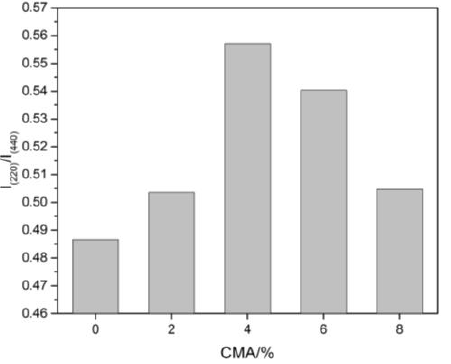
Figure 3. I (220) /I (440) of spinel within samples sintered at 1600 °C for 3 h.